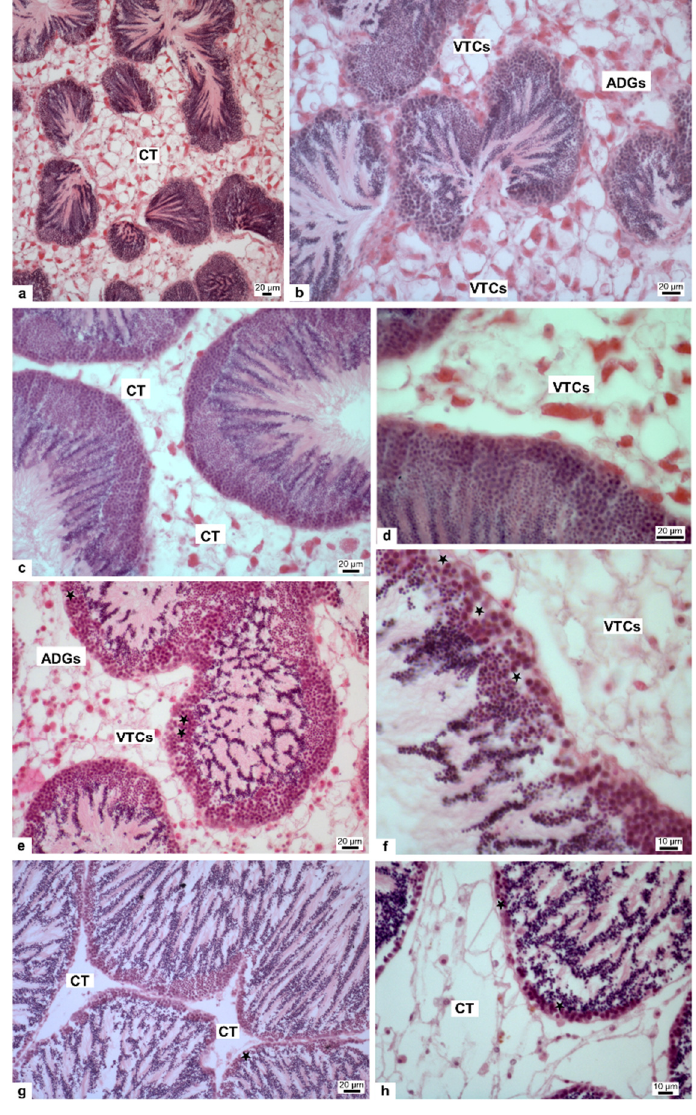
Figure 2. Staining of M. galloprovincialis gonad with hematoxylin and eosin. Gonad morphology of nonexposed ( a , b ) and exposed mussels to 1 ( c , d ), 10 ( e , f ) and 100 pM ( g , h ) HgCl 2 , respectively. CT: connective tissue; VTCs: vesicular connective tissue cells; ADGs: adipogranular cells; * (star): degenerative vacuolized areas.